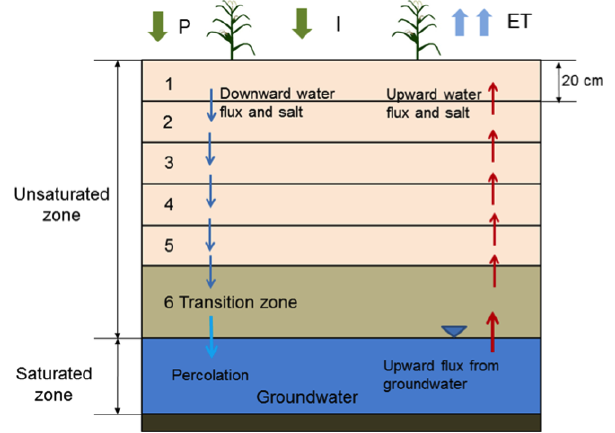
Figure 1. Schematic diagram of model components and water